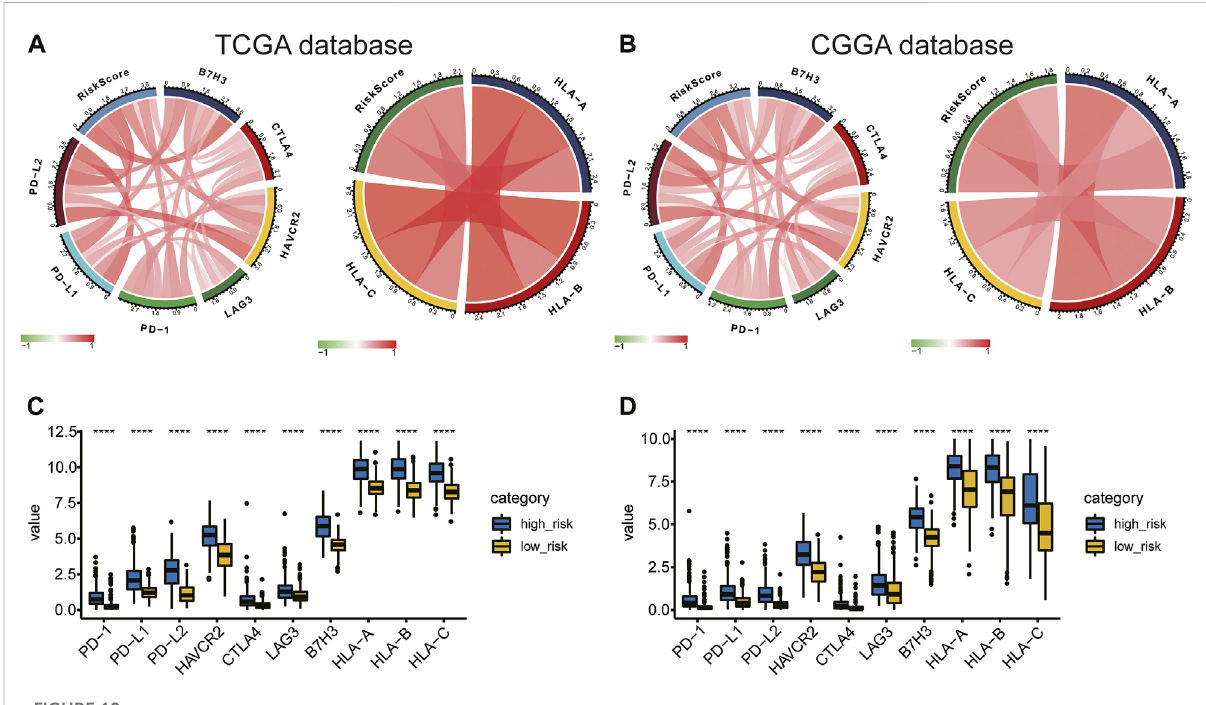
FIGURE 10 (A,B) Correlation of risk score to immune checkpoints and HLA complex expression levels. (C,D) Difference in expression of immune checkpoints and the HLA complex between the high- and low-risk